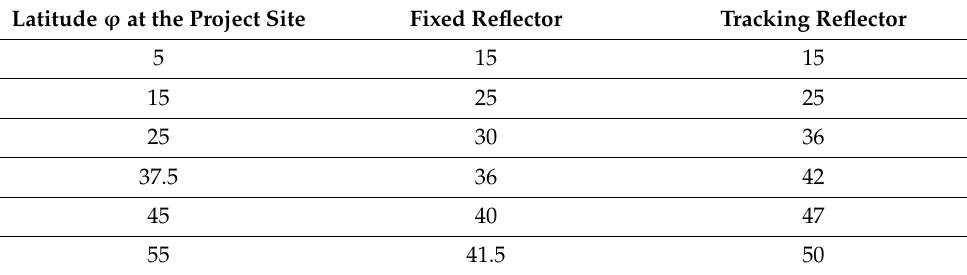
Table 3. Theoretical optimal tilt angle of the bifacial companion system ( ◦ ).